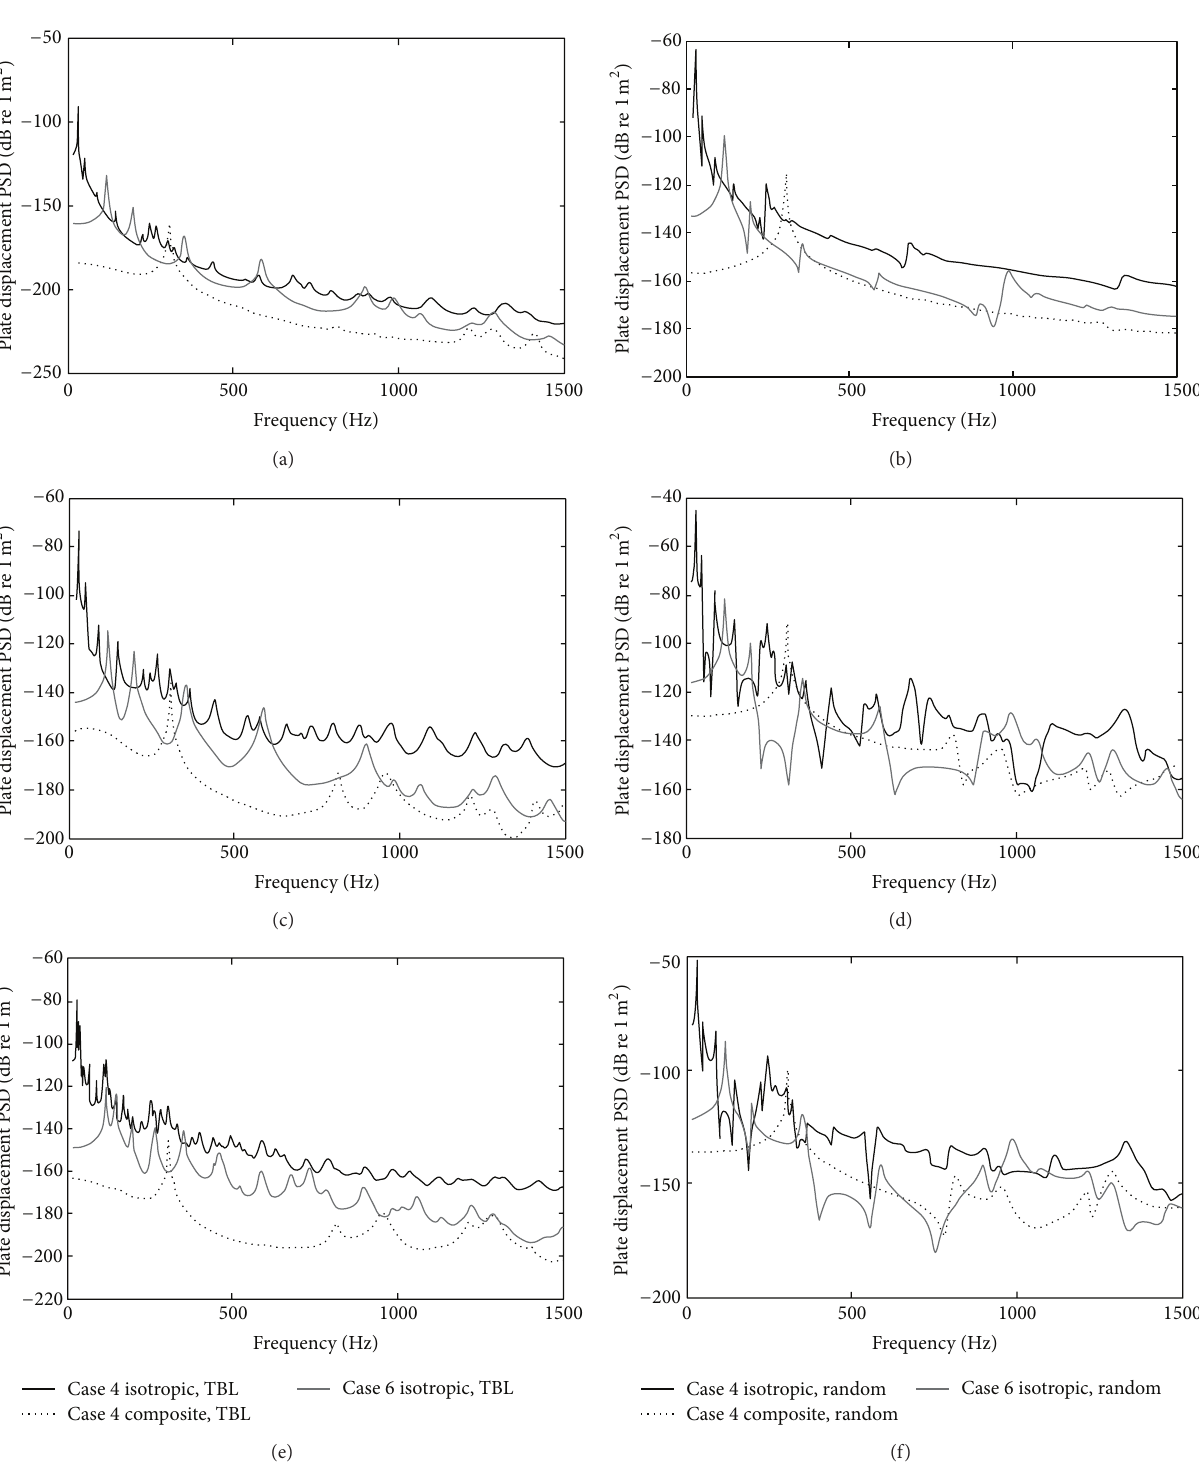
Figure 11: Comparison of panel displacement PSD results, for Case 4 composite panel versus Cases 4 and 6 isotropic panels: (a) and (b) overall panel 𝑆 𝑤𝑤 ; (c) and (d) 𝑆 𝑤𝑤 near surface location (𝑥 1 , 𝑦 1 ) = (0.5𝑎, 0.5𝑏) ; (e) and (f) 𝑆 𝑤𝑤 near location (𝑥 2 ,𝑦 2 ) = (0.3𝑎, 0.2𝑏)